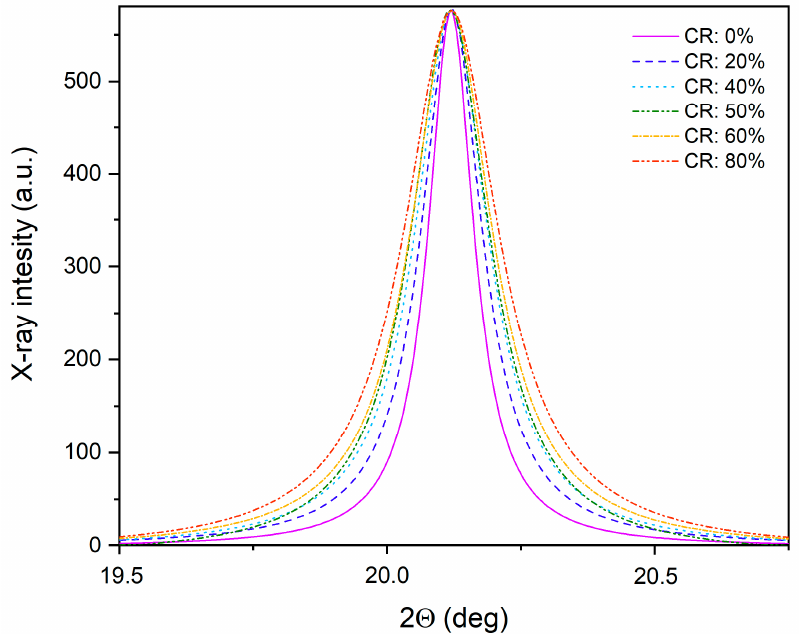
Figure 4. Effect of the cold rolling process on the {100} XRD peak profile of EUROFER97 steel. The broadening of the diffraction peaks is an index of the increase in the dislocation density ρ .